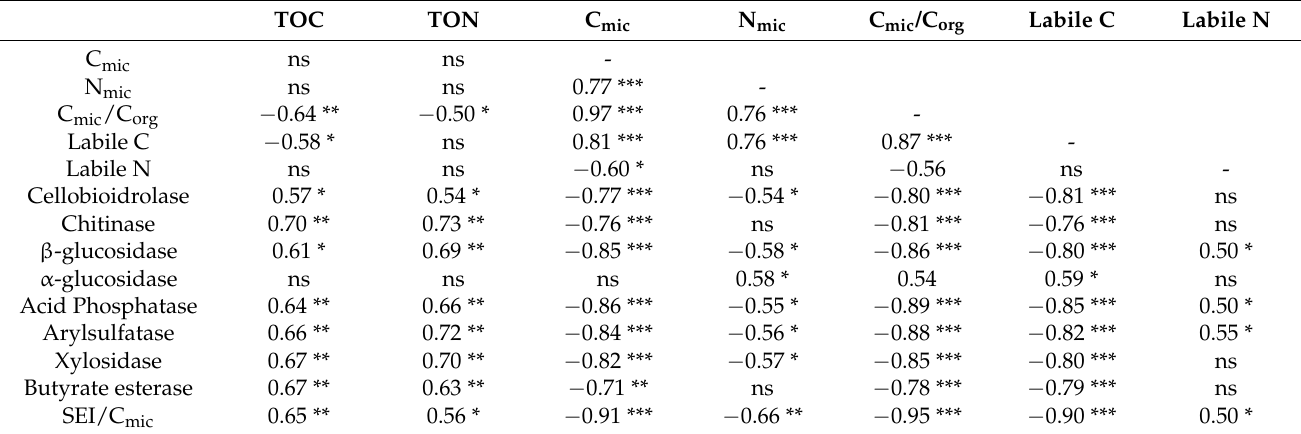
Table 4. Pearson’s correlation coefficient between C, N pools and enzyme activities of soil. TOC = Total organic carbon; TON = Total organic nitrogen; C mic = Microbial carbon; N mic =